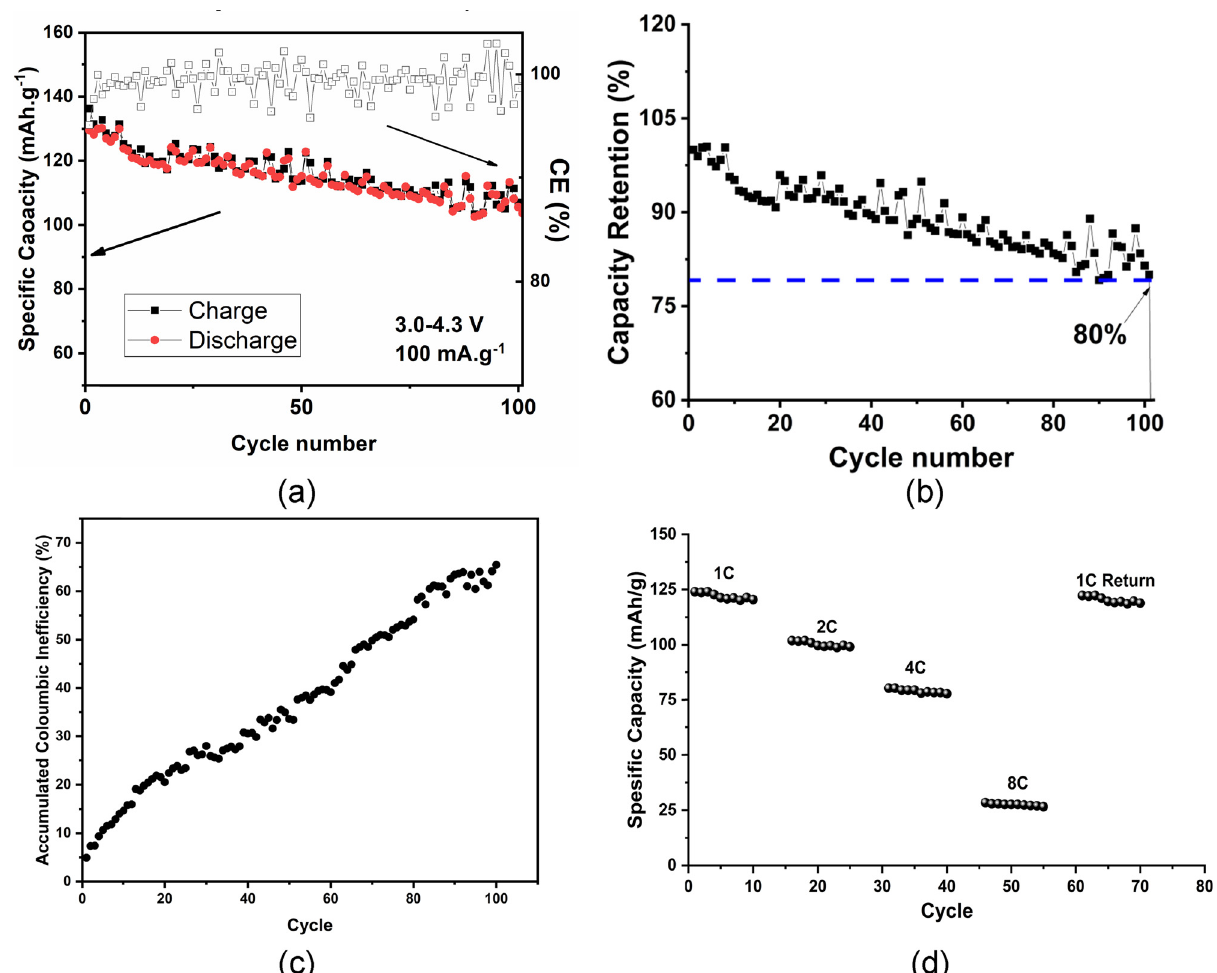
Figure 6: ( a ) Cycle performance, ( b ) capacity retention pro fi le, ( c ) accumulated coloumbic ine ffi ciency, and ( d ) rate ability of NCA/LiPF 6 / graphite cells.